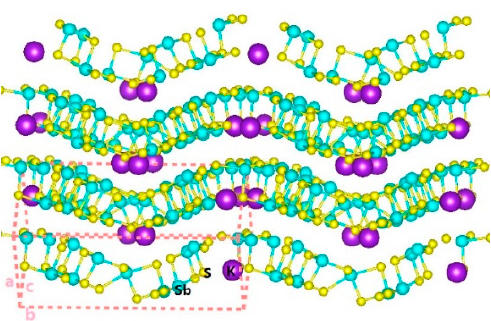
Figure 2. The schematic photograph of KSb 5 S 8 . Purple, cyan, and yellow balls indicate K, Sb, and S atoms, respectively.